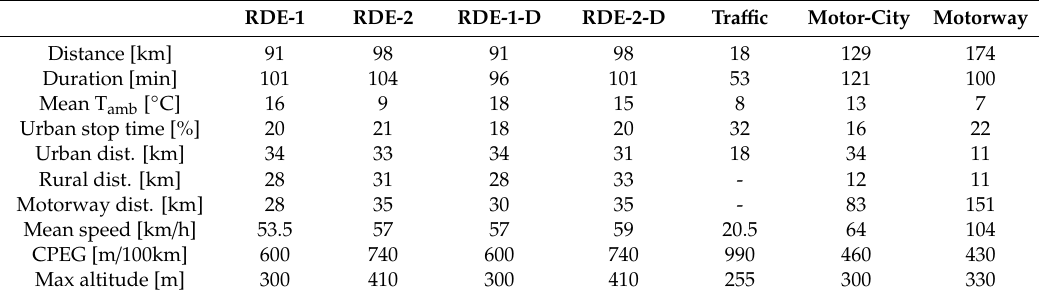
Table 2. On-road routes’ characteristics. The values reported for RDE-1 and Tra ffi c routes correspond to the averages of the two repetitions